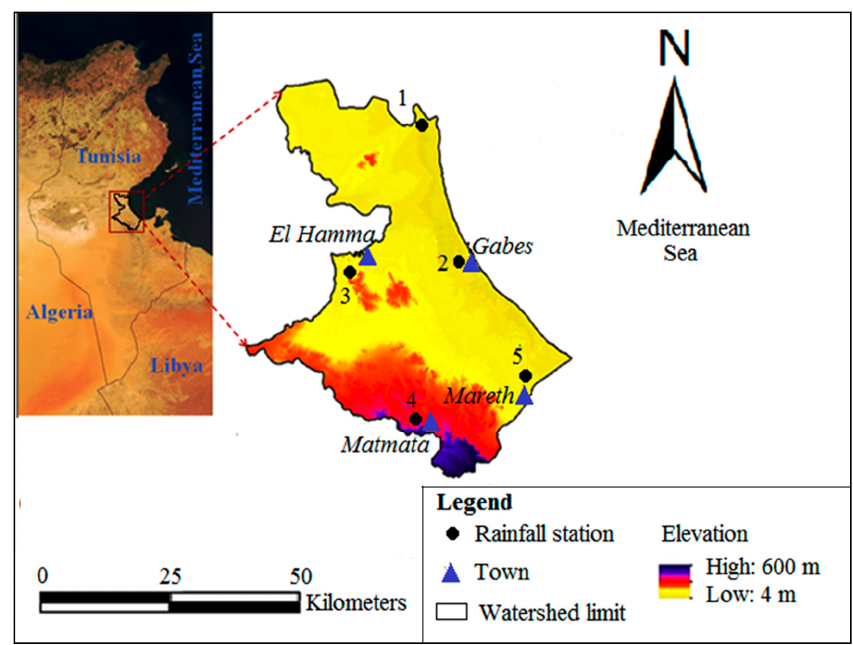
Figure 1. The Digital Elevation Model (DEM) of Gabes Watershed. (Jemai et al. [14], modified).